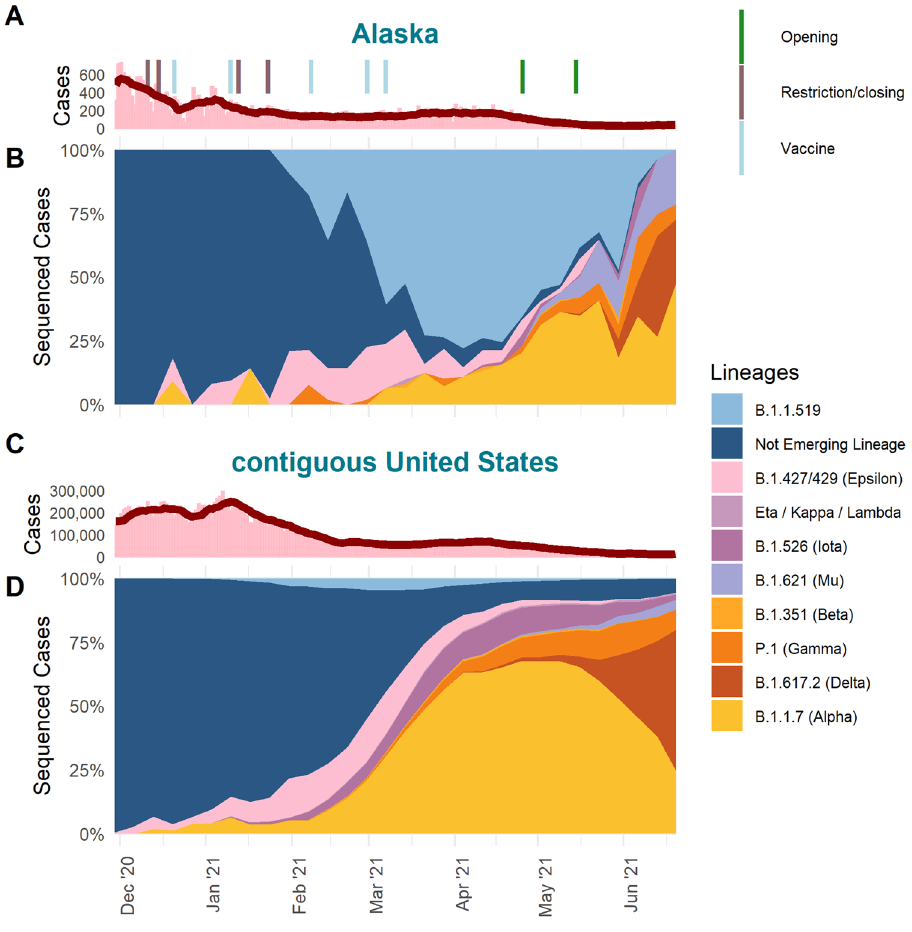
Figure 1. COVID-19 cases and variants in Alaska versus the contiguous United States. ( A,C ) Daily case count (bars) and seven day rolling average (red line) and ( B,D ) percent of sequences (estimated prevalence) by PANGO lineages detected by week from 2020-11-29 to 2021-06-26 for Alaska ( A,B ) and the contiguous United States ( C,D